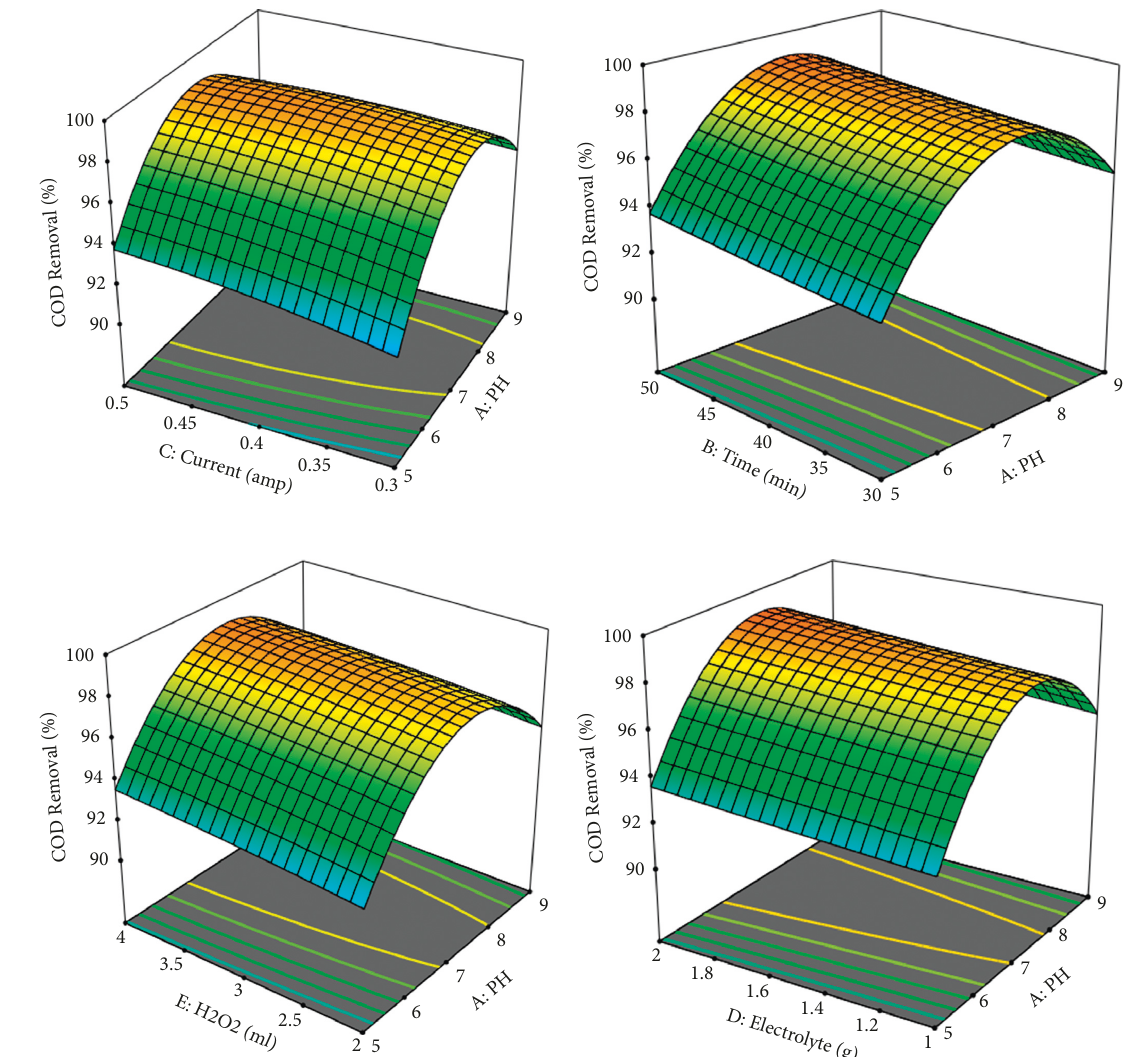
Figure 7: Interaction effect of independent variables 3D response surface plots for % removal of COD, by the combination of ECO with UV/ H 2 O 2 using CaCl 2